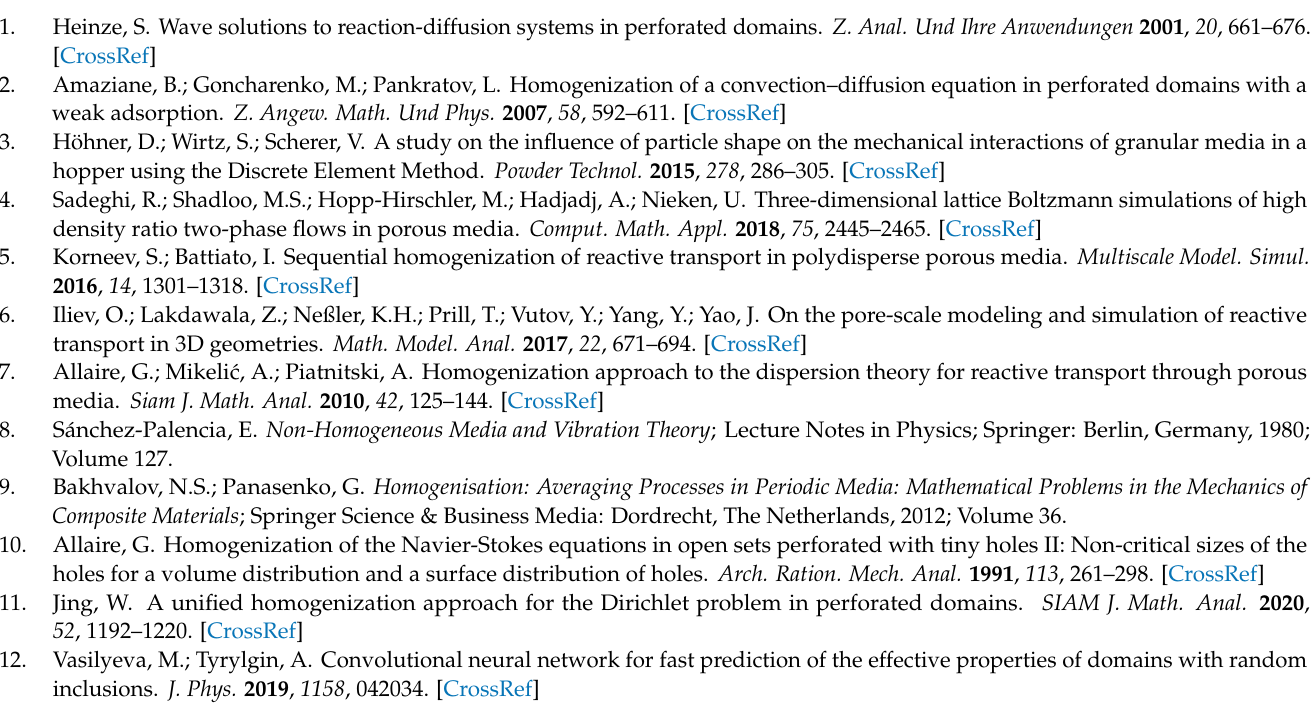
+ DOF T with DOF u = 170,460 and DOF T = 85,230). Second h h h h + DOF T = 5988 and with DOF u H H H